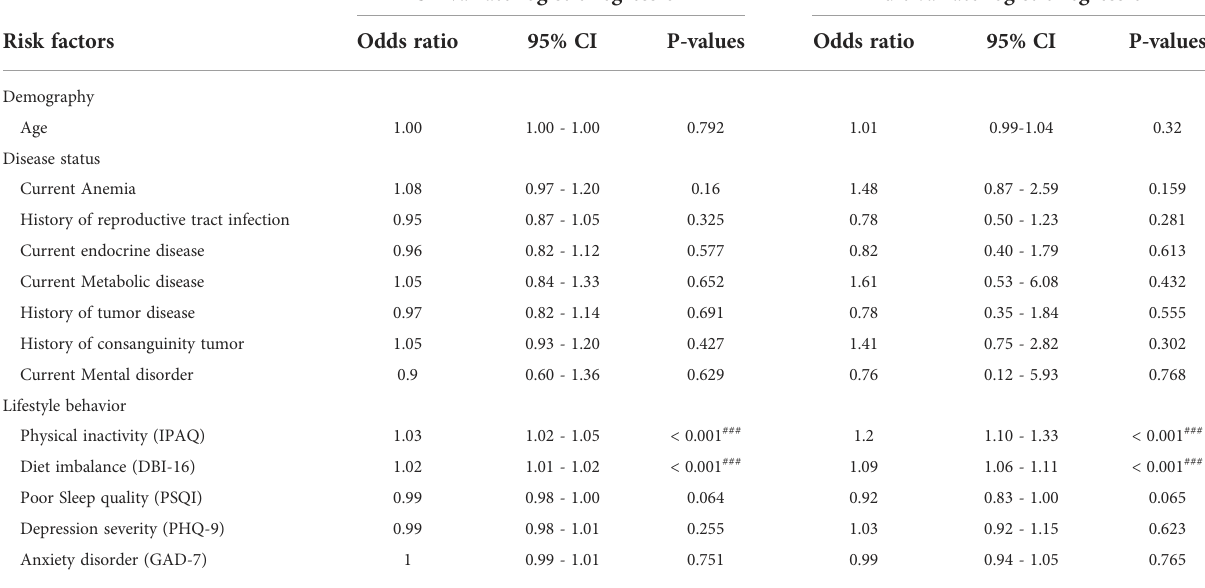
TABLE 2 Univariate and multivariate logistic regression for all